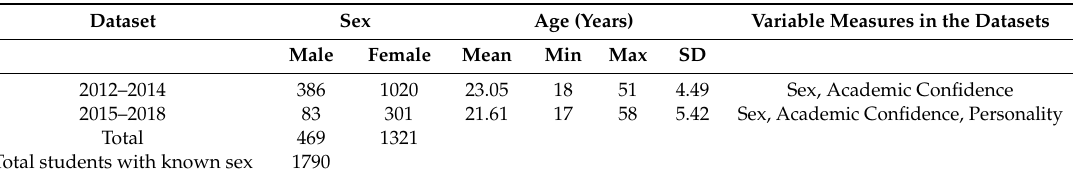
Table 1. Participant profile for the two component